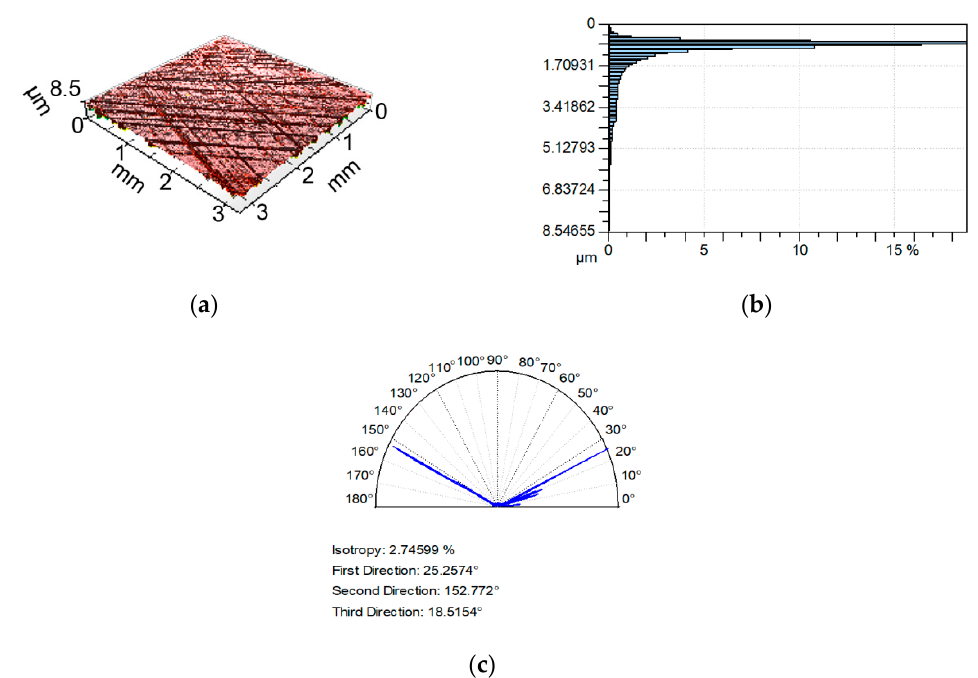
Figure 5. Isometric view ( a ), ordinate distribution ( b ), and directionality plot ( c ) of surface texture after plateau honing.